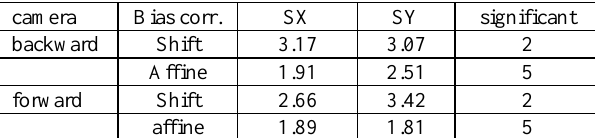
Table 1. Accuracy of bias corrected RPC-orientation at 12 GCPs and number of significant affinity parameters 5 of 6 affine parameters of the two-dimensional bias correction are significant. By bias correction with affinity transformation